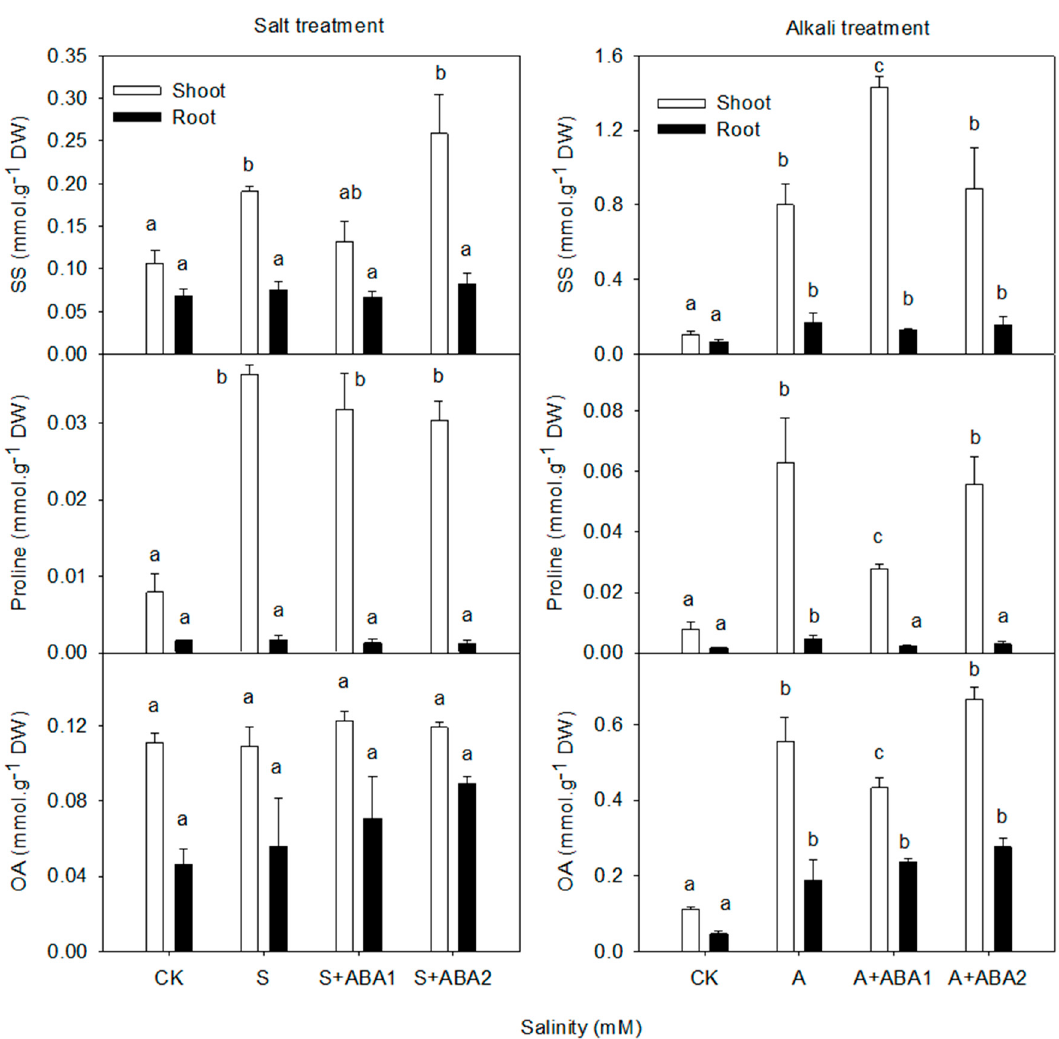
Figure 3. Effect of salt and alkali stress, with or without ABA treatment on the concentration of the main organic solutes in shoots and roots. Means with different letters in columns with different colors are significantly different ( p < 0.05).